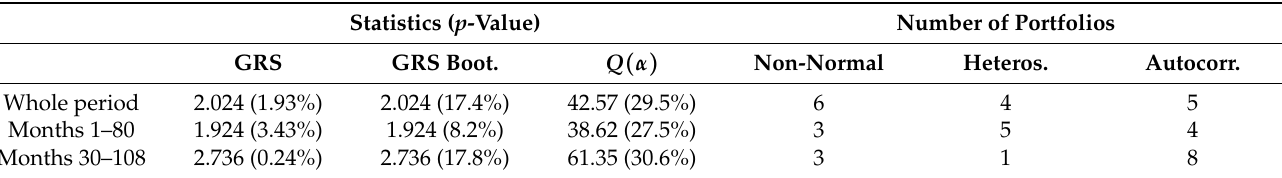
Table 6. Metrics for CAPM with different time